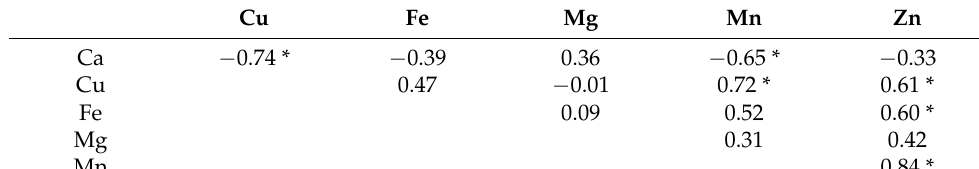
Table 1. The values of the correlation coefficients for the content of analytes in the tissue of men. Statistically significant values are marked with an asterisk.